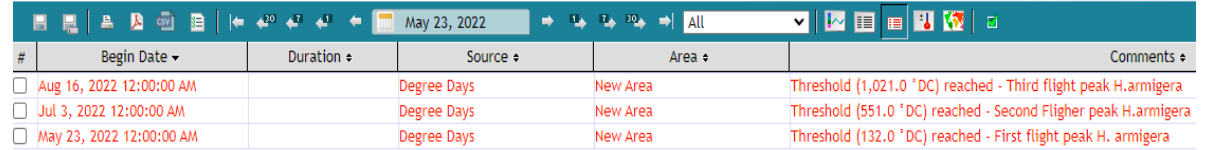
Figure 7. A representative meteorological station ( a ) and its location in the Prespa lake area in the prefecture of Florina ( b ). Graphical User Interface (GUI) and real time software outputs of: mean, max and min temperature online sensor indications ( c ), mean (blue), max and min (green) daily temperature recordings (1 January 2021 so far) ( d ), pest risk thresholds indications and their dura ‐